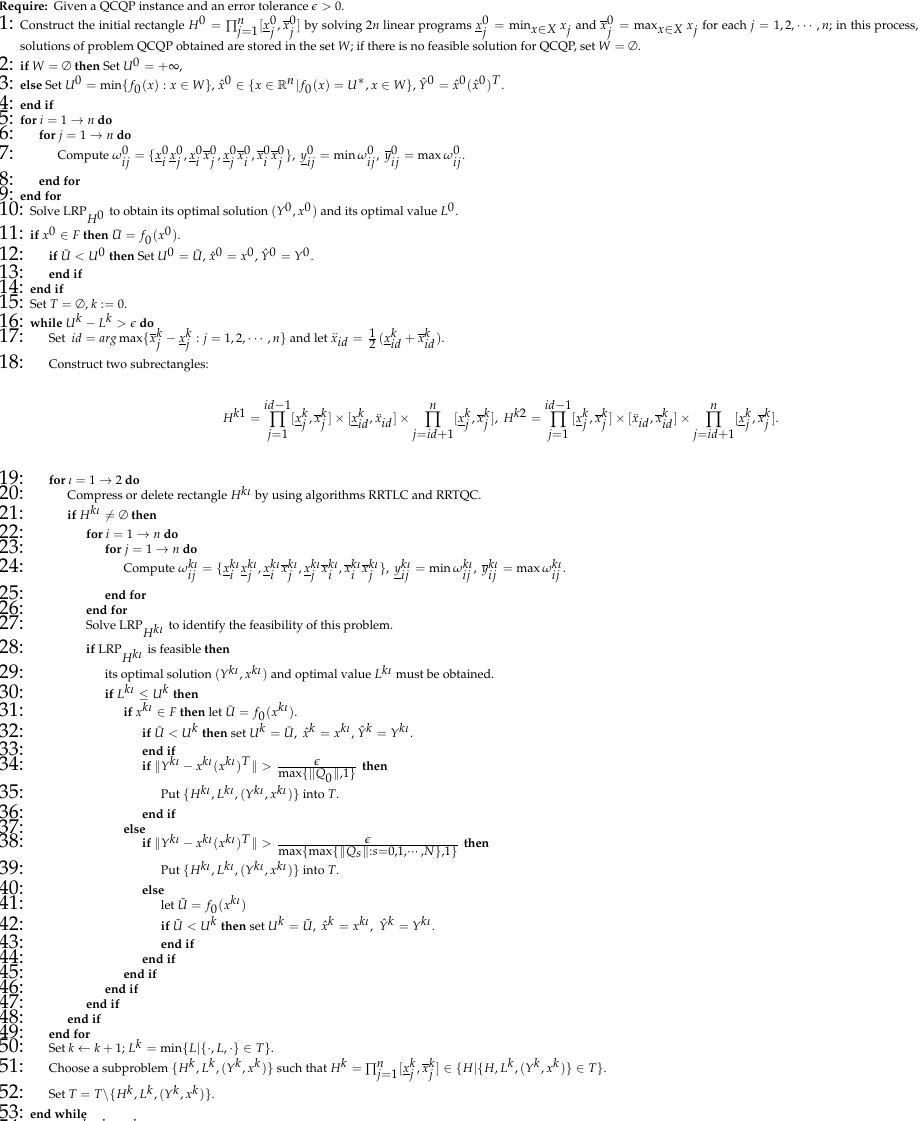
Algorithm 3 Relaxation-and-Bound